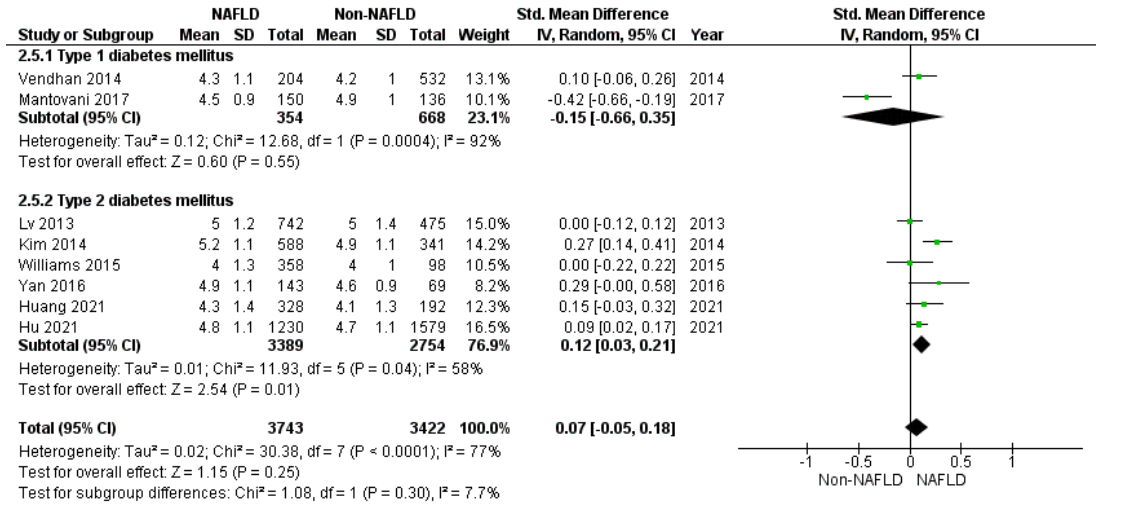
Figure 5. Forrest plot displaying total cholesterol serum levels expressed in mmol/L, comparing diabetic patients with and without NAFLD. Data are expressed as a standard mean difference, evaluated by applying a random effect model.